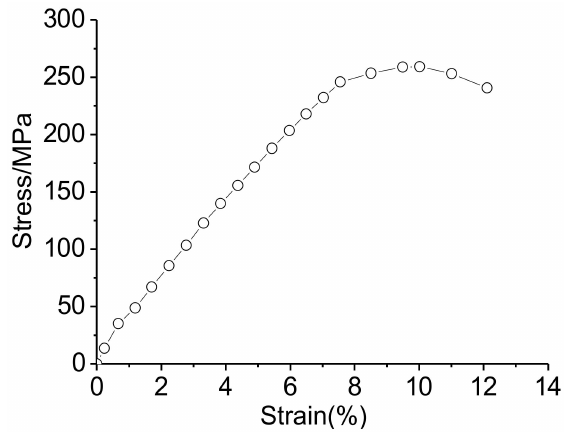
Figure 3. Geocell stress–strain curve.